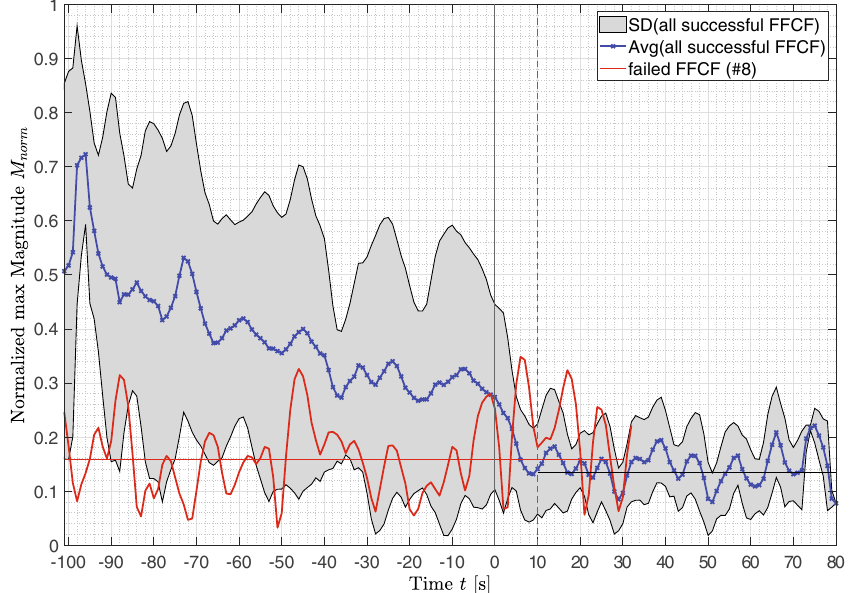
Figure 3. Extracted normalized magnitudes of all prepared flaps located at the forearm. The blue curve represents the mean of all flaps and the gray area is the SD ( n = 14 ). In comparison, the red curve shows the extracted normalized magnitude of failed case 8 (with its average as a horizontal red line). The data are normalized with the averaged magnitude of the analyzed healthy unprepared flaps (recording #1—flap baseline). The time point t = 0 s marks the closure of the radial artery and the beginning of ischemia. After t = 10 s, the used time window is completely in ischemia. The horizontal black line marks the ischemia baseline. The closure of the veins happened in the time window t = − 56.2 s ± 34.4 s showing a first continuous decrease in magnitude values.